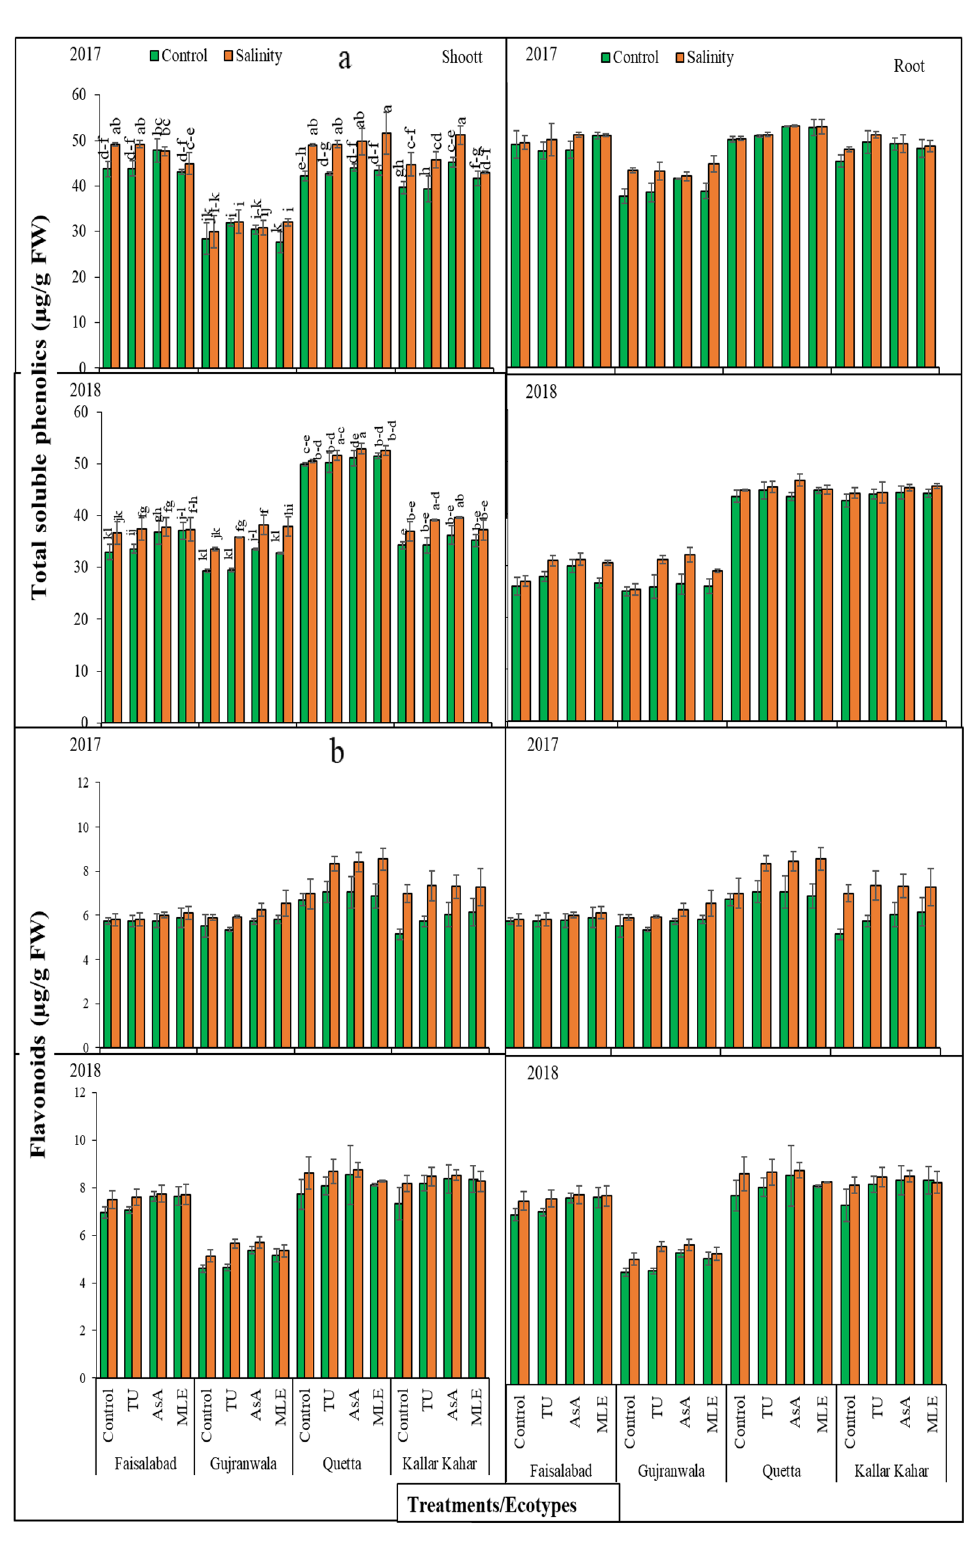
Figure 3. ( a ) Total soluble phenolics content, and ( b ) flavonoid content of root and shoot of milk thistle under control and salinity stress conditions. The plants were soil supplemented with different plant growth promoters during 2017 and